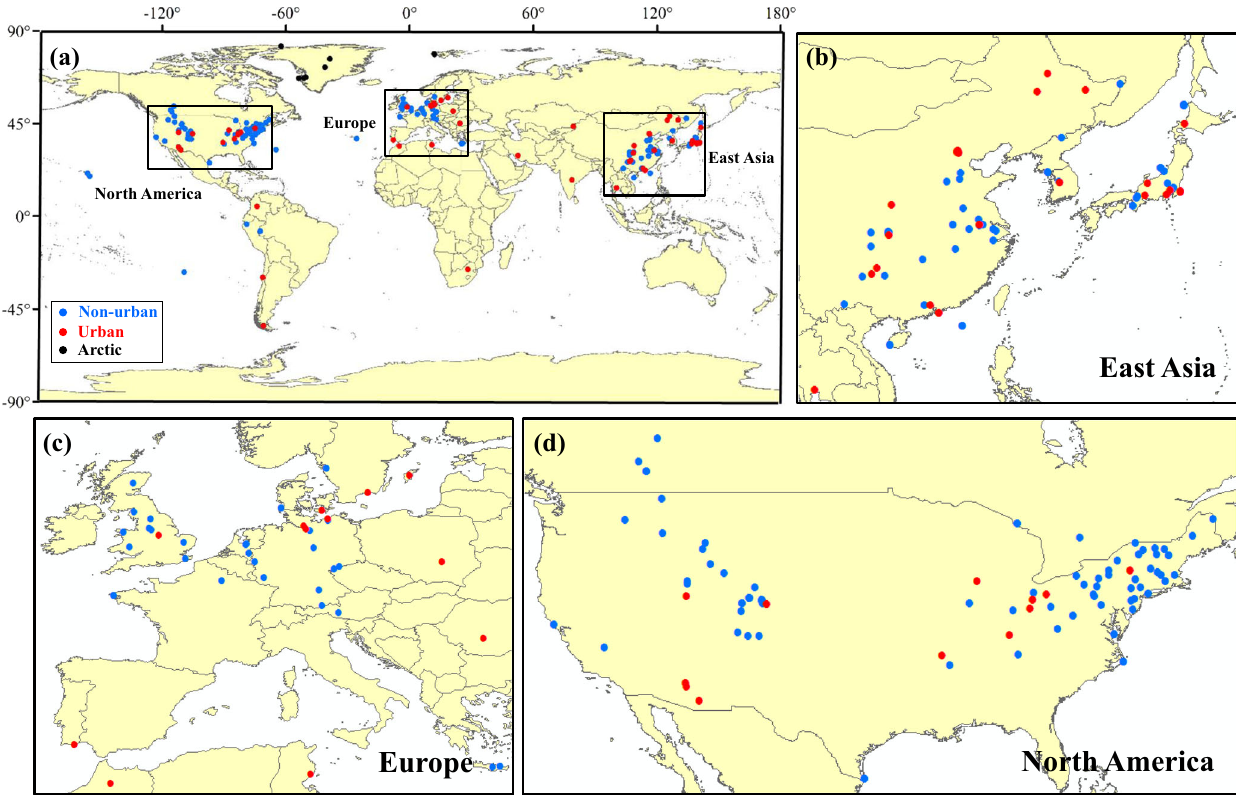
Fig. 1 Study sites with δ 15 N w-NO3 − observations. Red, blue, and black dots represent urban sites ( n = 56), non-urban sites ( n = 158), and Arctic sites ( n = 8), respectively.